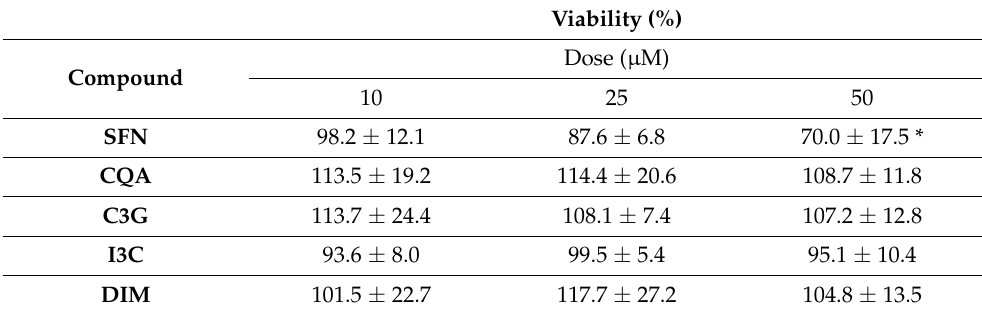
Viability (%) Dose ( µ